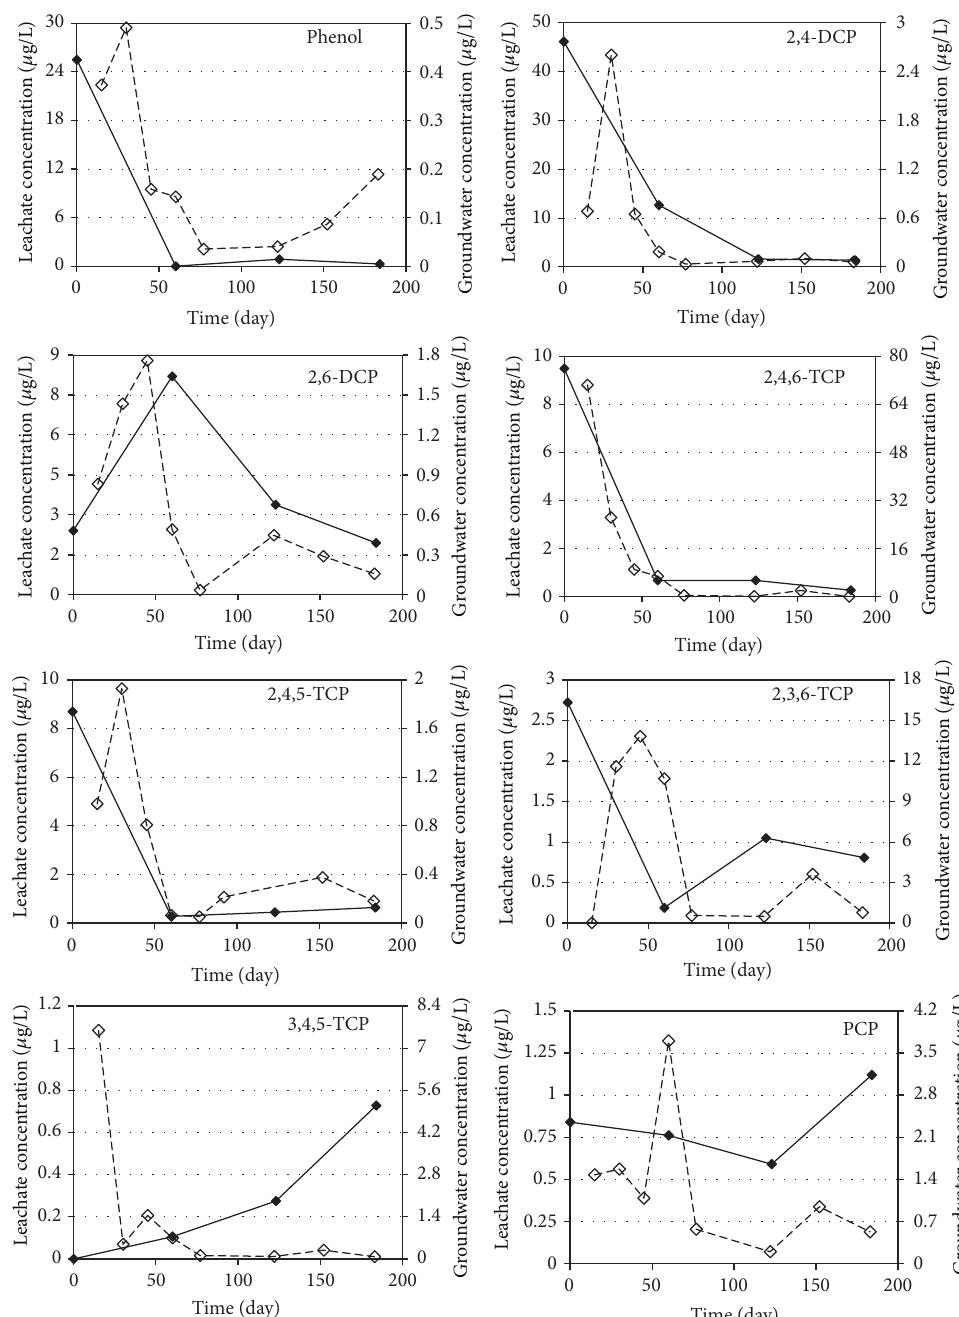
Figure 4: Variations of the phenolic compounds in groundwater and leachate samples of R3 reactor (——: leachate concentration, -----: groundwater